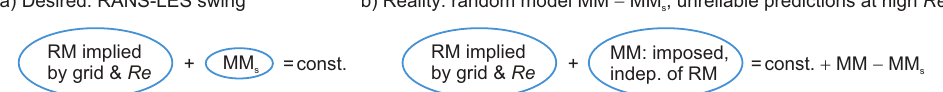
Figure 2. Problem P 1 illustration. MM (RM) refers to modeled (resolved) motion, and MM s is MM implied by swing. ( a ) Desired: RANS-LES swing. ( b ) Reality: random model MM – MM s , with unreliable predictions at high Re